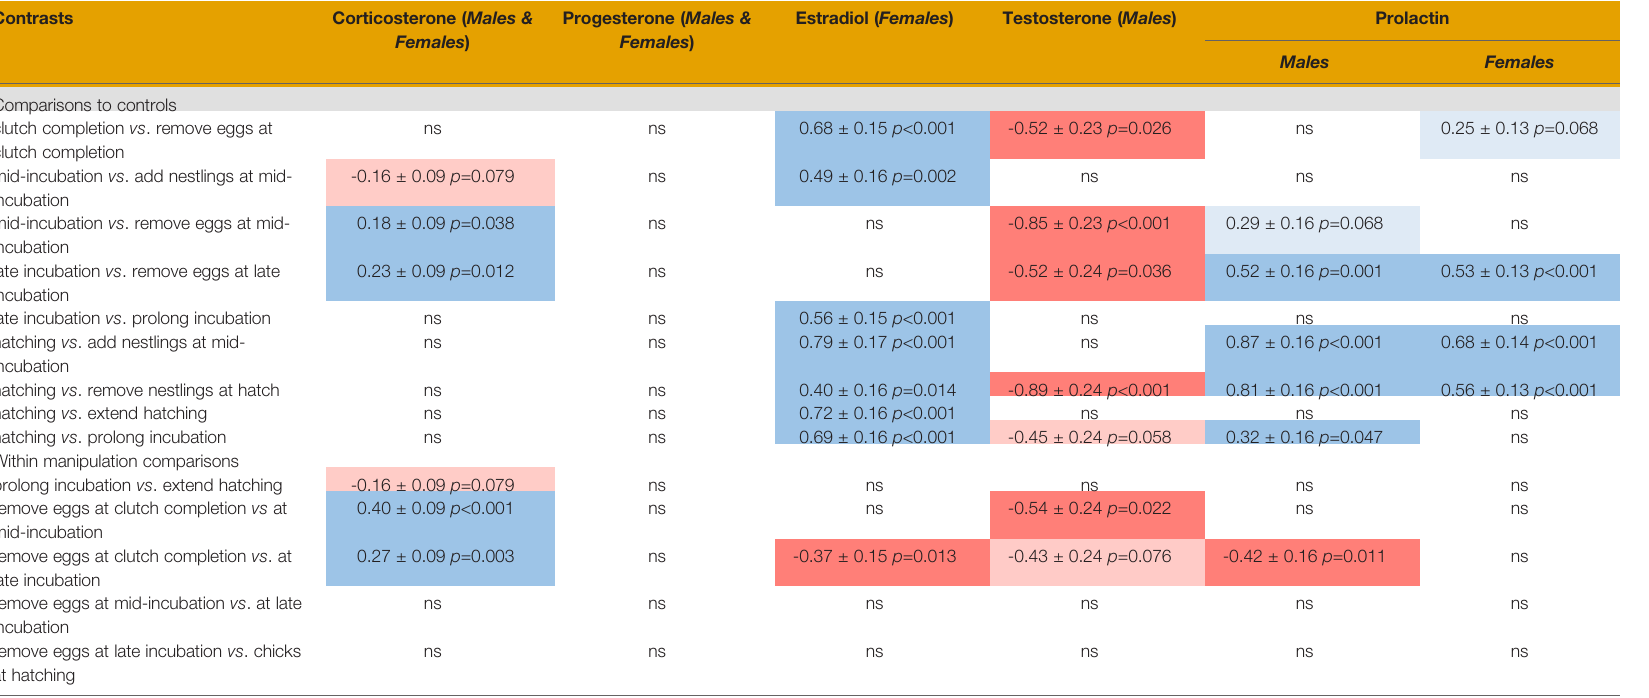
Progesterone ( Males & Estradiol ( Females ) Testosterone ( Males ) Prolactin Females ) Females )